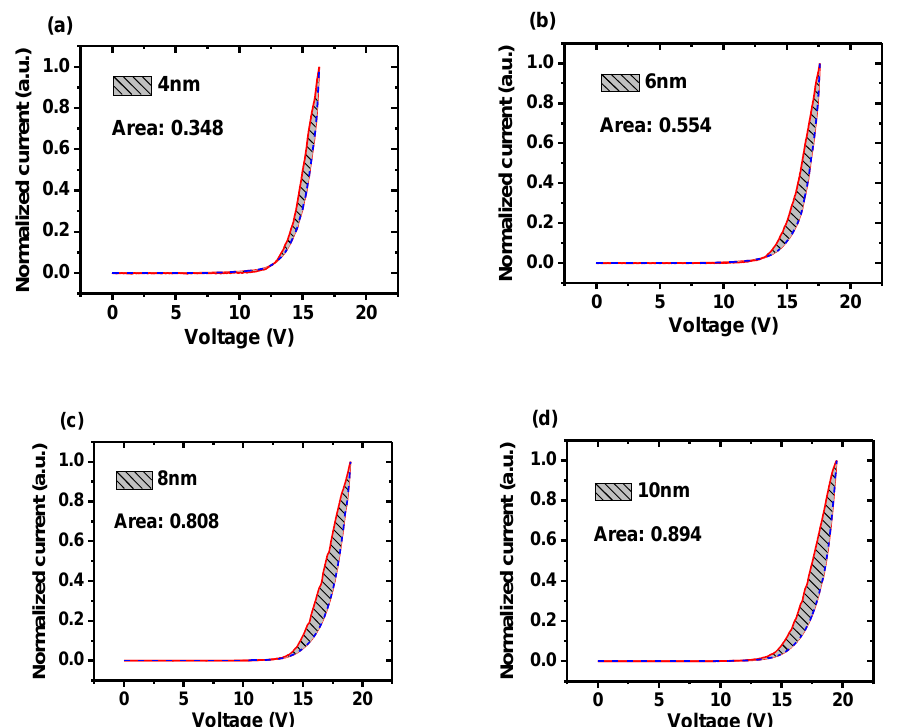
Figure 4. The normalized current and photo current of devices with PMMA of thicknesses of ( a ) 4 nm ( b ) 6 nm ( c ) 8 nm and ( d ) 10 nm. The areas between the two curves are 0.348, 0.554, 0.808, and 0.894, respectively.